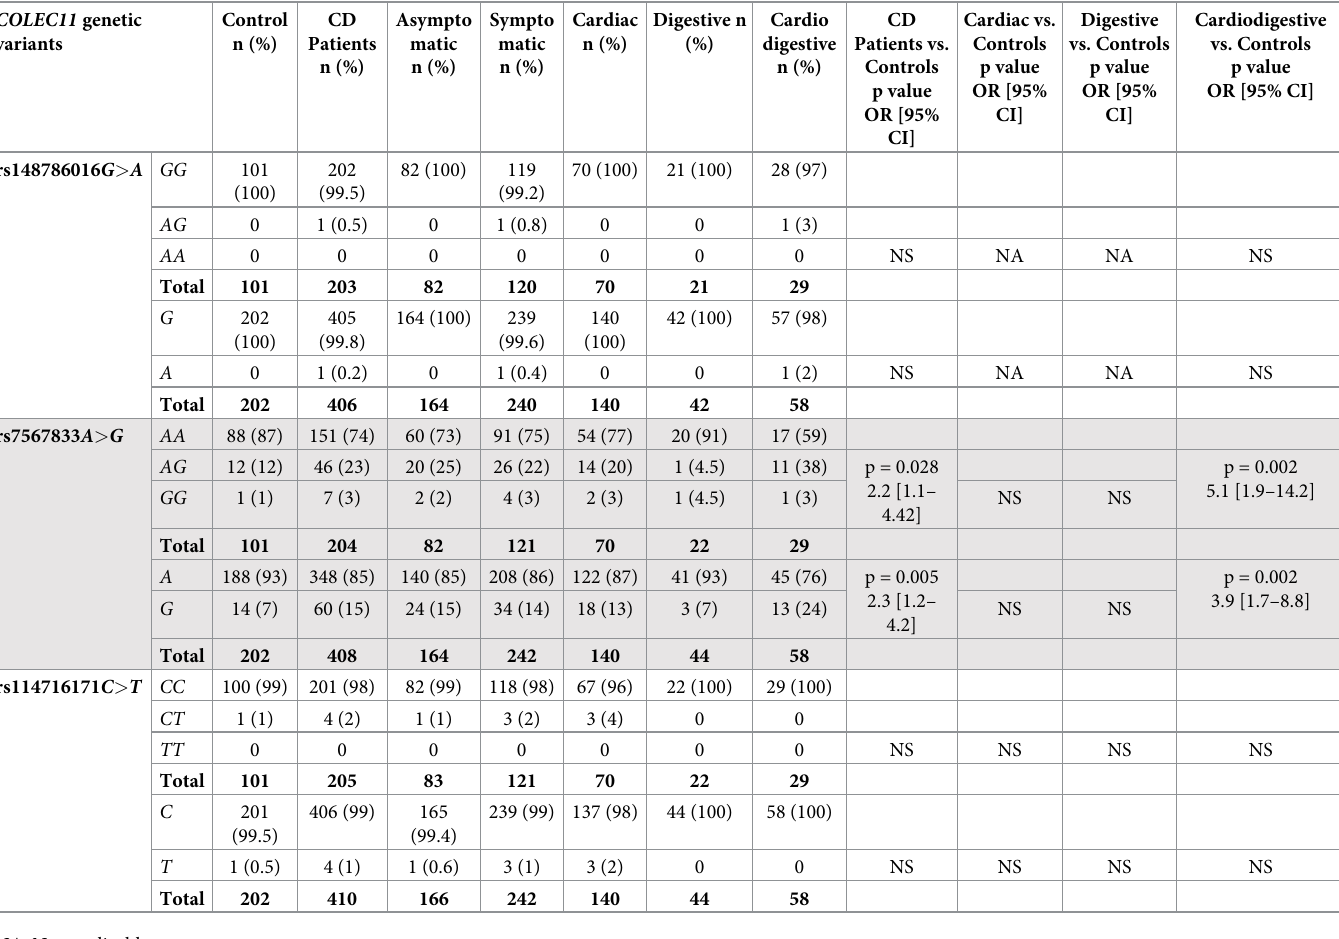
Table 2. COLEC11 genotypes and alleles frequencies in patients with chronic CD and healthy controls. COLEC11 genetic